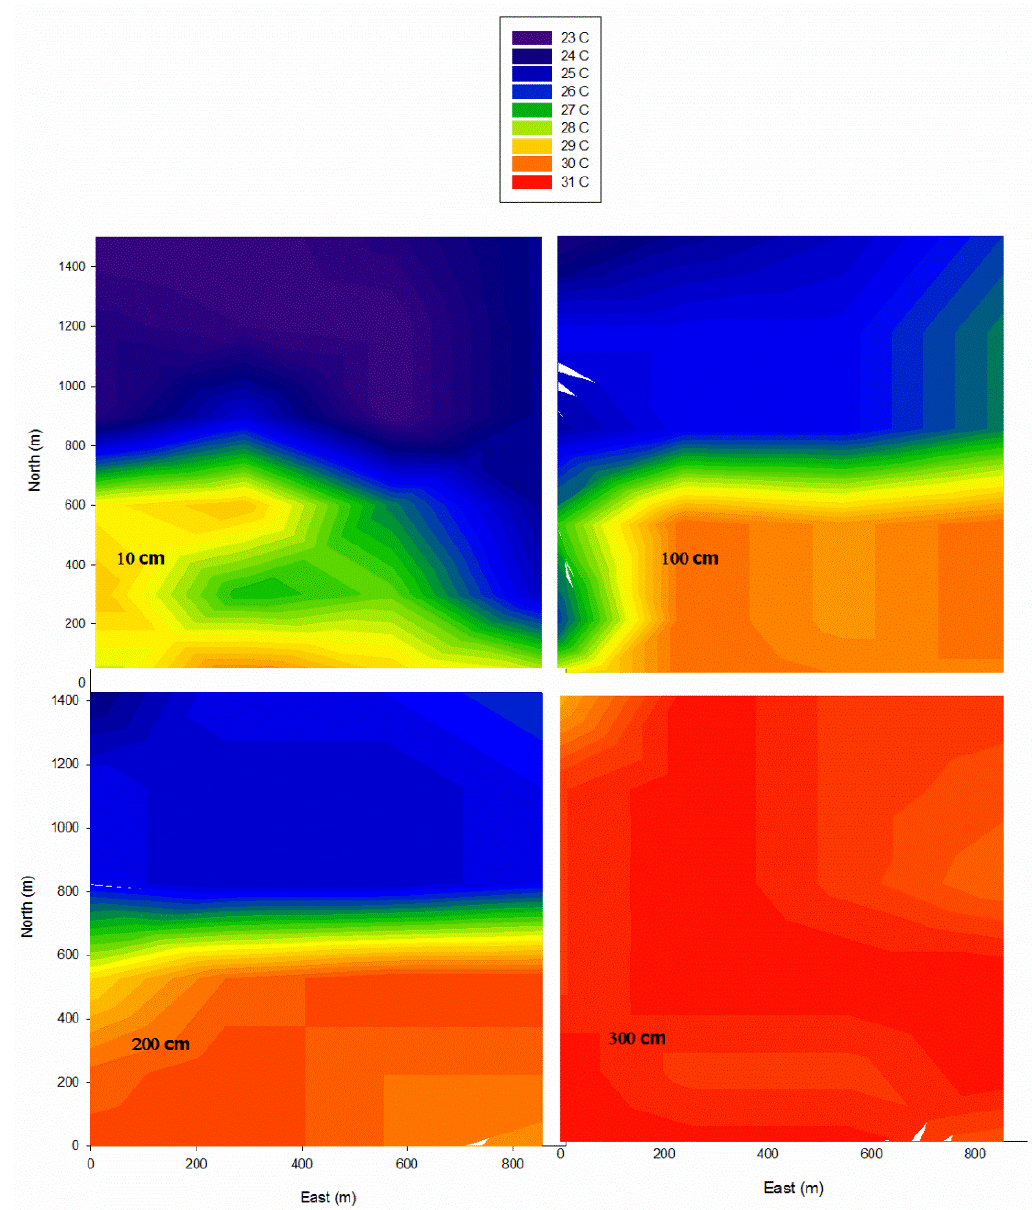
Figure 11. Air temperature at 0700 hour on 1 September at heights of 10, 100, 200 and 300 cm within the down gradient creosote bursage plant community. The solar facility was located approximately 100 m upgradient from the lower west to east edge of the monitoring area (see site location map).